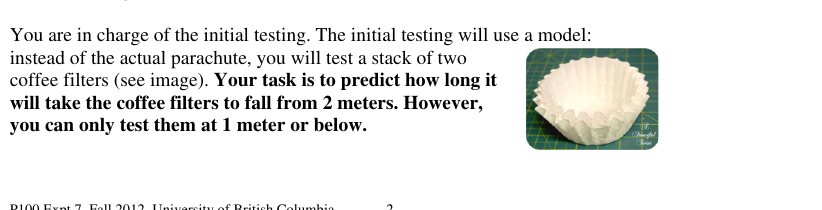
FIG. 5. Page 2 of the TA version of the lab